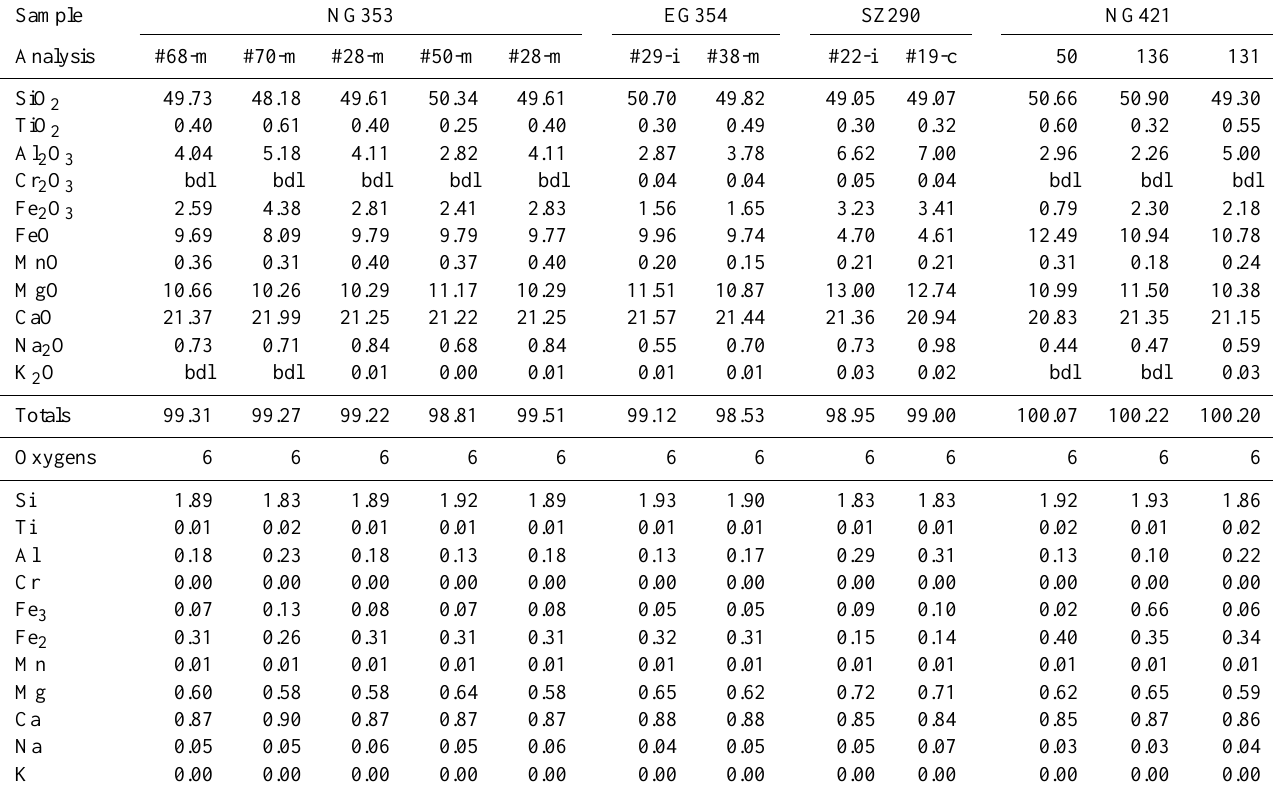
Table 4b. Representative EMPA analyses of